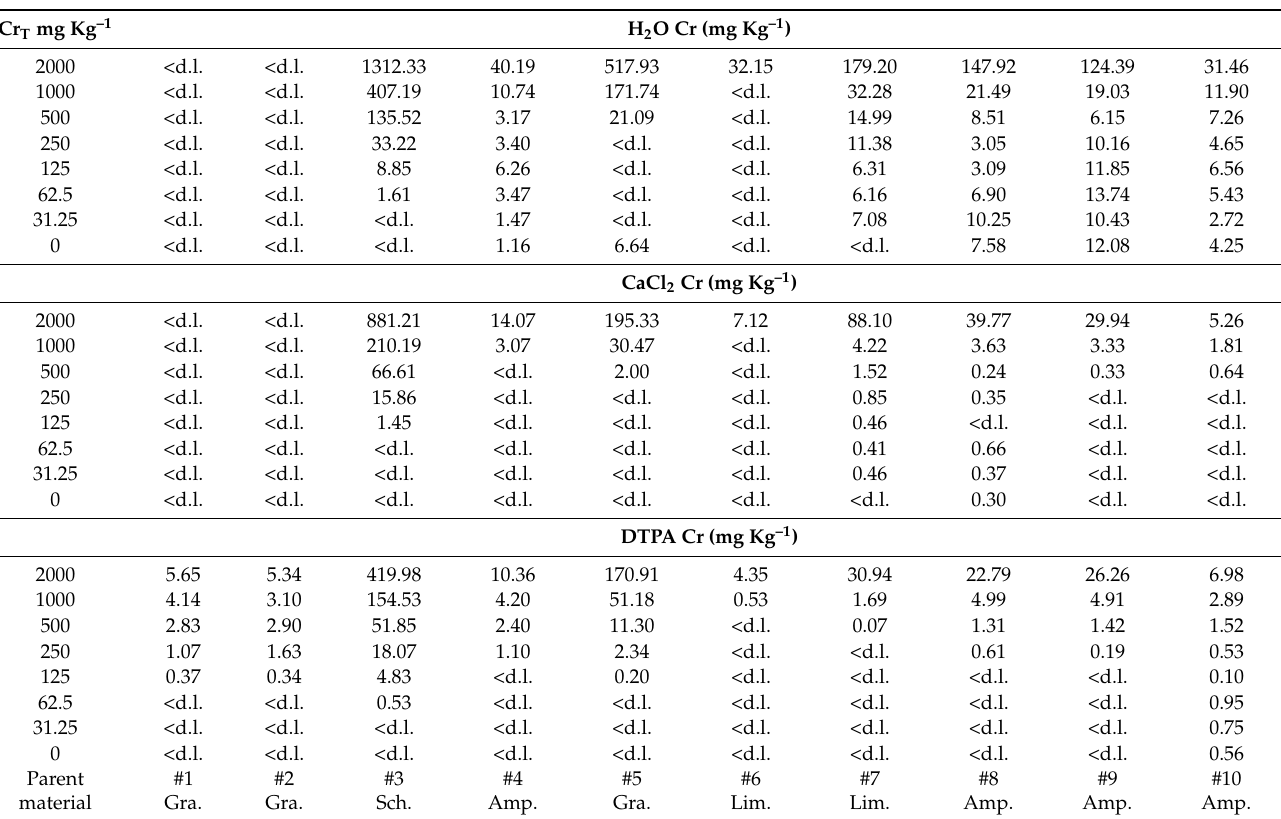
Table 3. Results of Cr extraction using H 2 O, CaCl 2 and DTPA, as a function of the added concentration, for the ten soils used. The parent material of each soil as also been included in the bottom. Cr T mg Kg –1